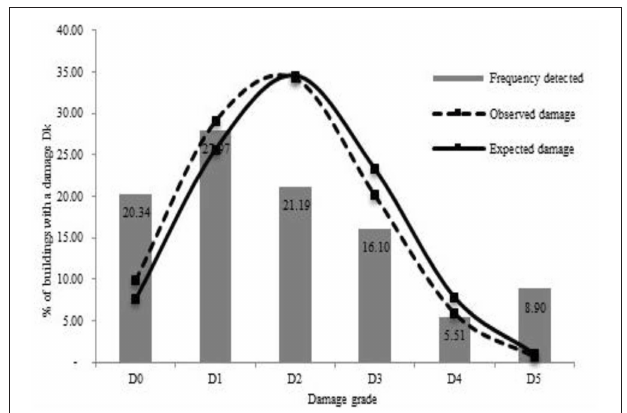
FIGURE 11 | Comparison between the observed frequencies and the binomial distributions evaluated according to the observed and the predicted mean